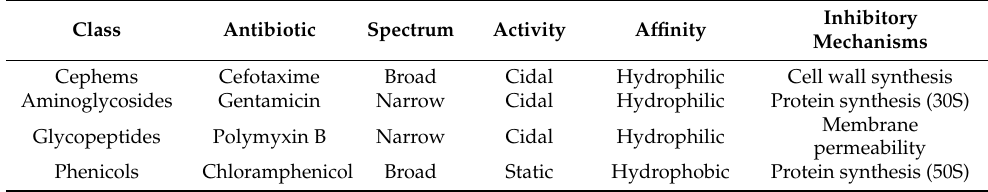
Table 1. Antimicrobial property of antibiotics used in this